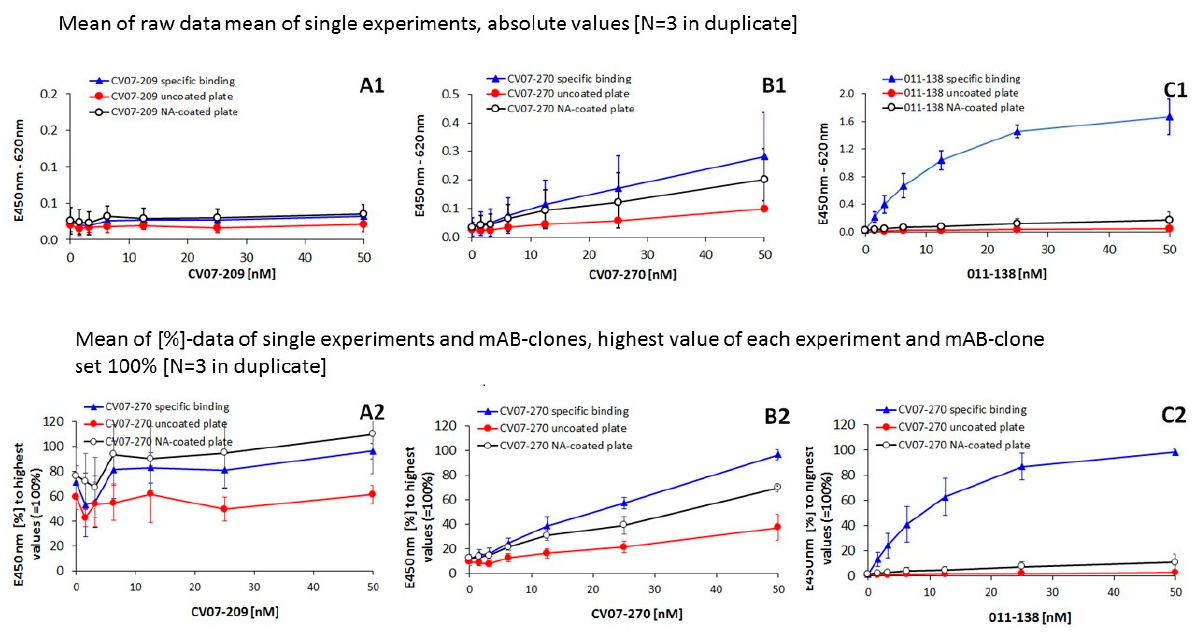
Figure 3. Binding of monoclonal antibodies onto immobilized BC 007. Upper row presents raw data of ( A1 ) neutralizing anti-SARS-CoV-2 antibody CV07-209 (highly specific) and ( B1 ) neutralizing SARS-CoV-2 antibody CV07-270 (showing also cross-reactivity [21]) in comparison to ( C1 ) a BC 007-affine monoclonal antibody that activates beta1-adrenoceptors (clone 011-138, origin: Kreye et al., unpublished). Lower row data are in percent, with the highest value of each experiment and clone set to 100%: ( A2 ) CV07-209, ( B2 ) CV07-270, and ( C2 ) 011-138. Shown in each case is the specific binding onto immobilized BC 007 (blue line), the nonspecific binding onto immobilized NeutrAvidin (the carrier for BC 007–biotin, control, black line), and the nonspecific binding of the mABs onto the carbonate buffer activated but noncoated plastic plate (control, red line). Note the different axis scales with the raw data ( A1 , B1 , C1 ), which were chosen to show details clearly.